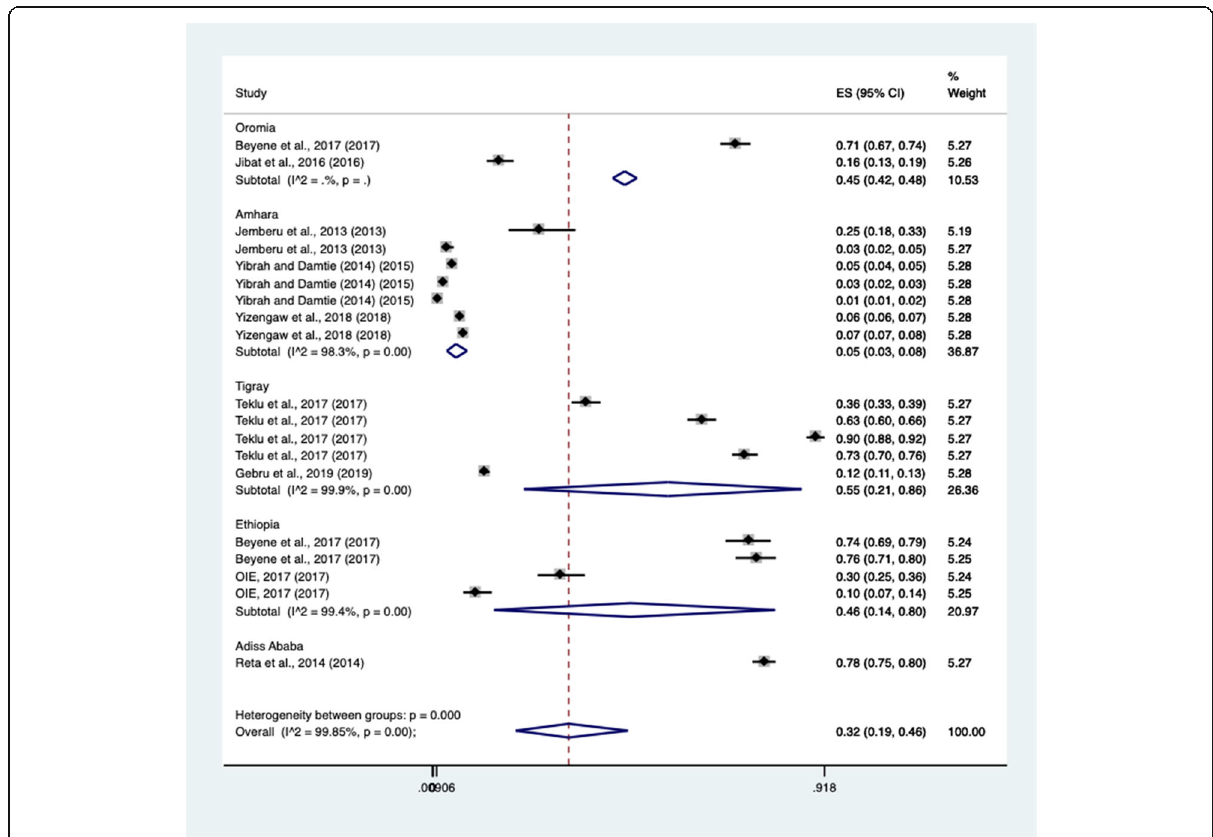
Fig. 4 Subgroup meta-analysis by study regions